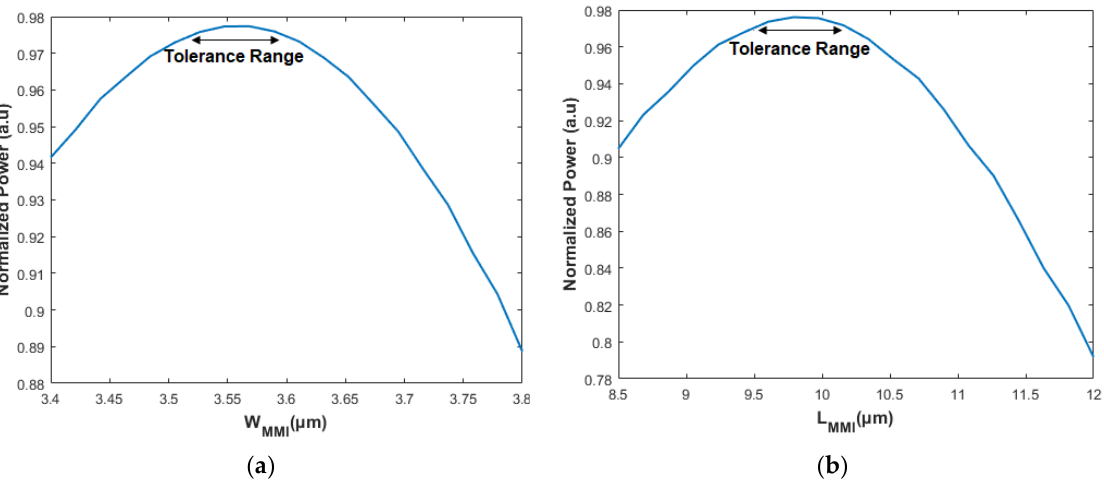
Figure 3. Normalized power as a function of the MMI combiner coupler key parameters: ( a ) W MMI ( b ) L MMI .